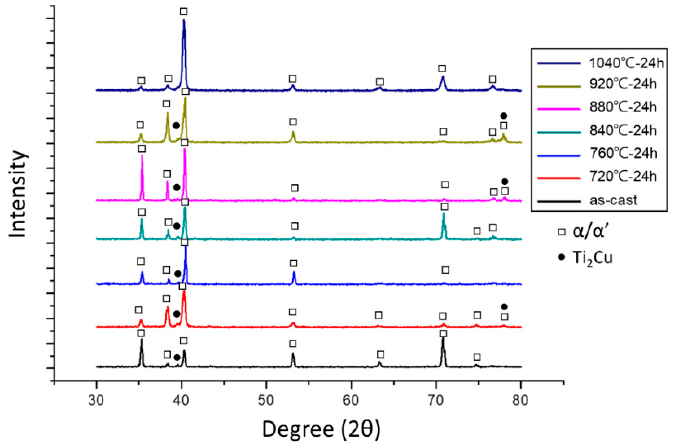
Figure 3. The X-ray diffraction (XRD) patterns of the Ti-5Al-2Cu alloys after different heat treatments. TEM electron micrographs of the Ti-5Al-2.5Cu alloy obtained after annealing at 920